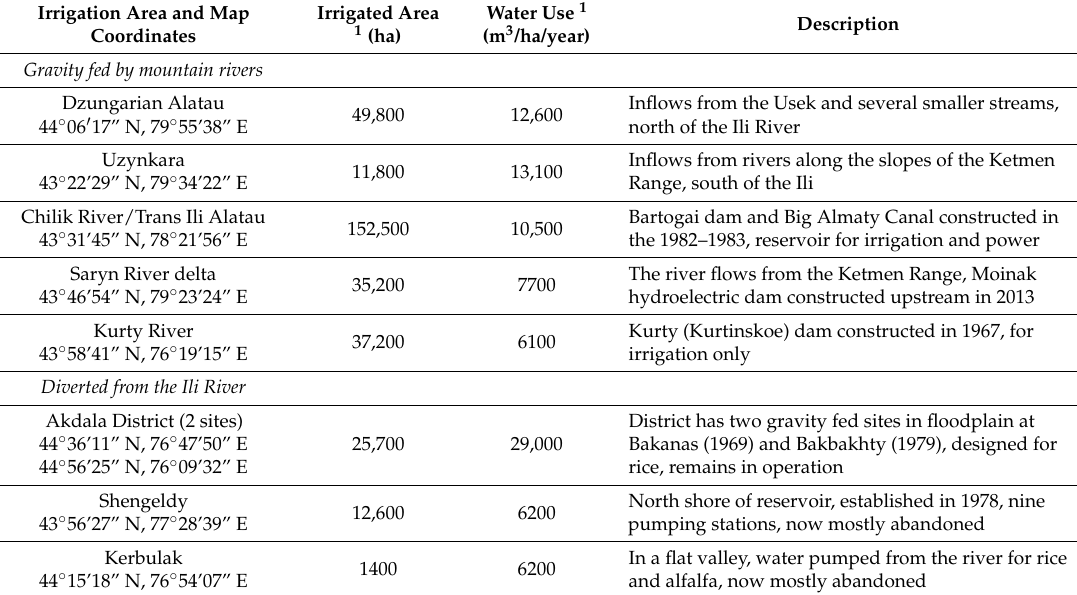
Table 3. Characteristics of irrigation areas in the lower Ili River